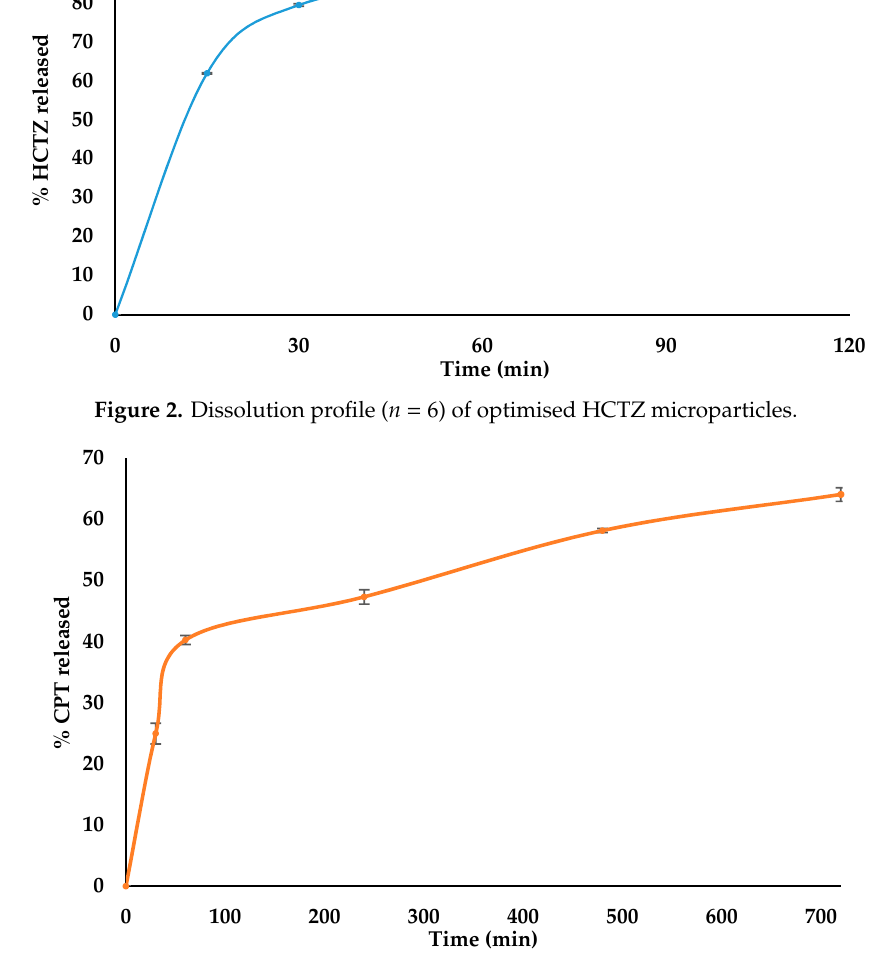
Figure 3. Dissolution profile ( n = 6) of optimised CPT microparticles.